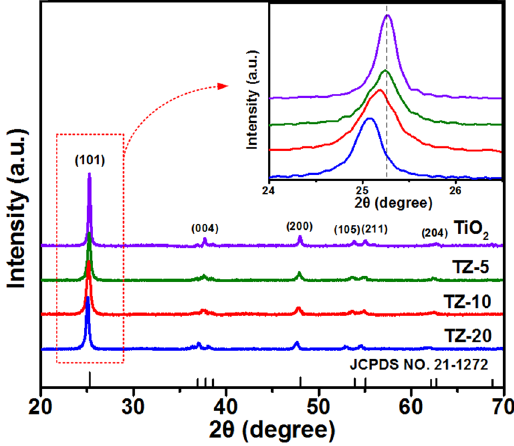
Figure 2. XRD patterns of TiO 2 , TZ-5, TZ-10, and TZ-20 nanofibrous membranes. The inset shows the enlargement of the XRD peaks for the (101)